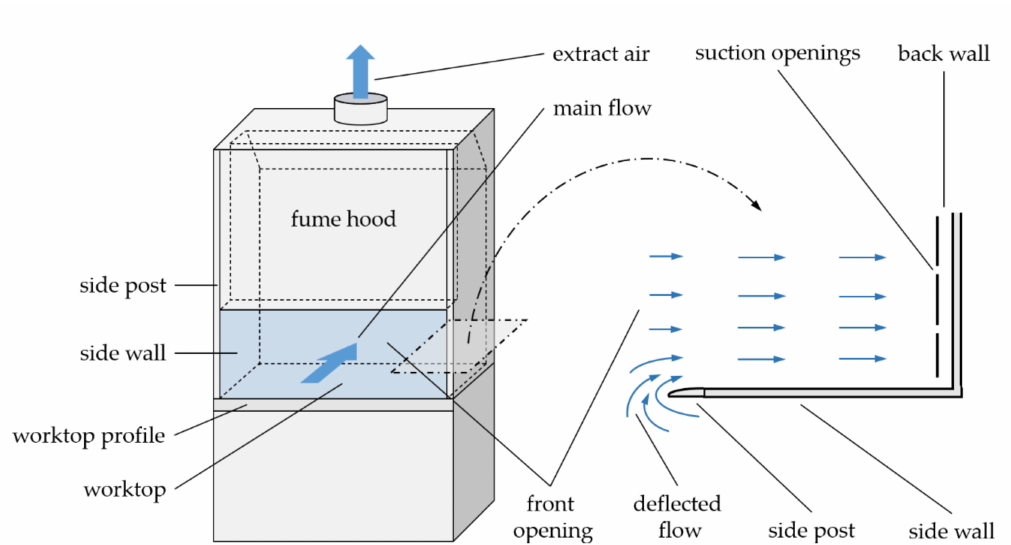
Figure 1. Fume hood with main components and flow deflection at the side post—schematic representation.